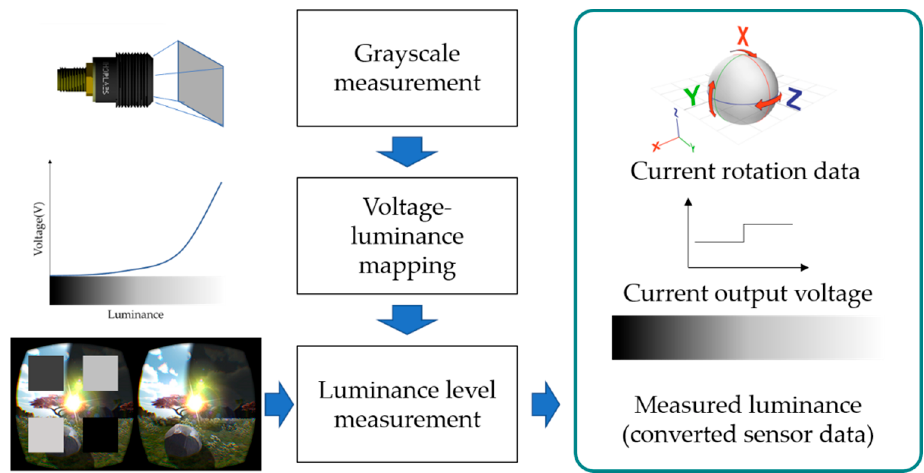
Figure 5. Luminance estimation from an object rendered by using the photodetector system and the voltage mapping table.